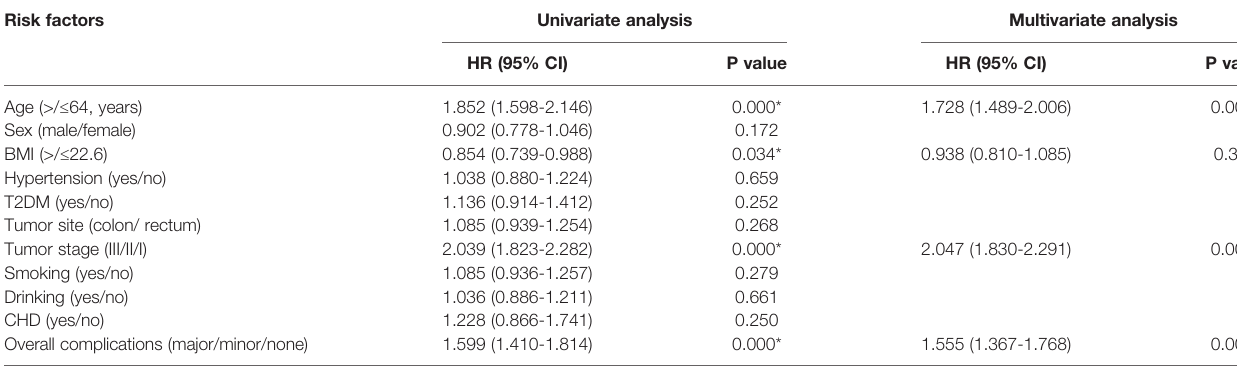
TABLE 4 | Univariate and multivariate analysis of disease-free survival. Risk